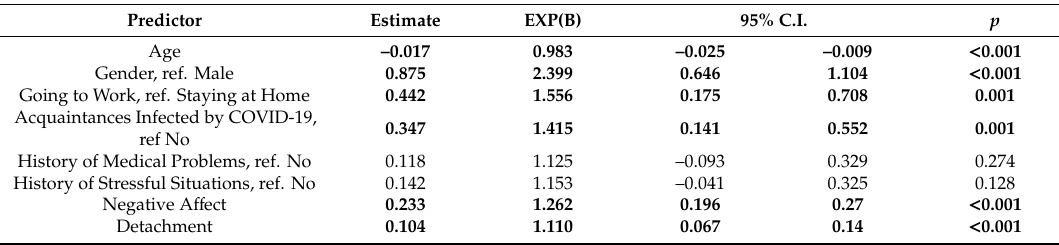
Table 6. Association between significant sociodemographic variables, personality traits, and DASS-21 stress during the COVID-19 outbreak ( n =